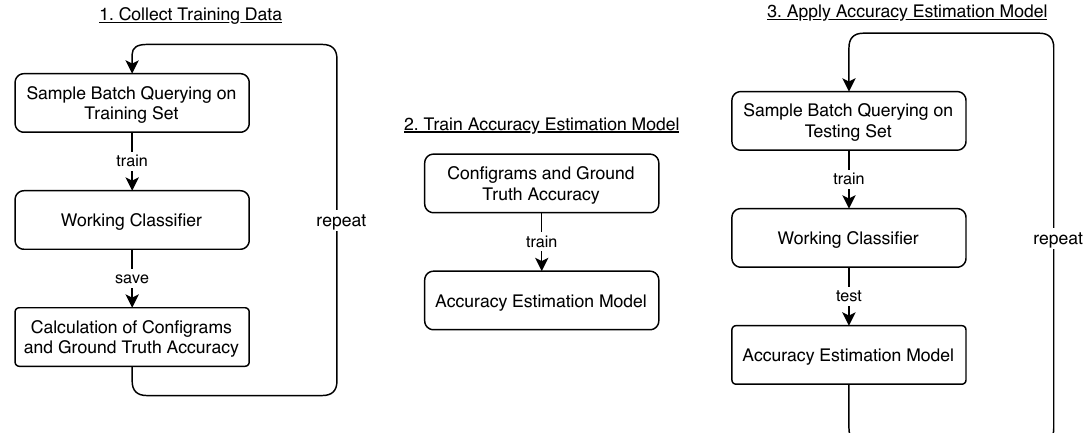
Figure 3. Workflow of accuracy estimation.